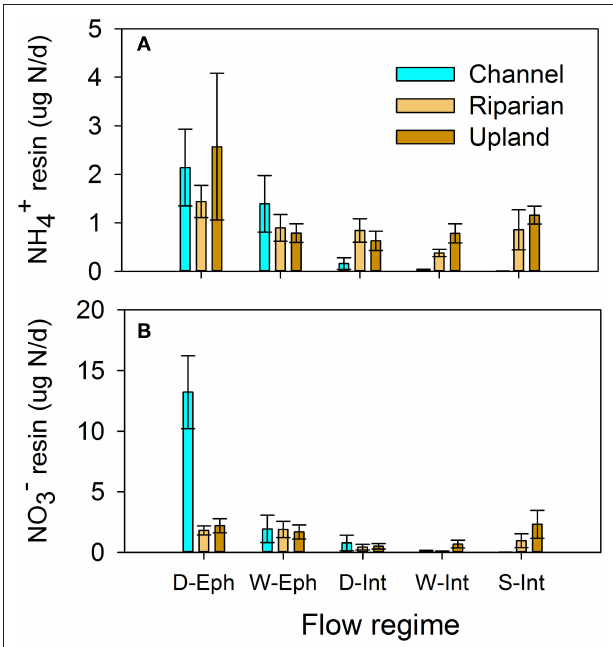
FIGURE 8 | (A) Ammonium and (B) nitrate availability as measured by resin bags and normalized by total days deployed during the monsoon across flow regimes, Dry ephemeral (D-Eph), Wet-ephemeral (W-Eph), Dry-intermittent (D-Int), Wet-Intermittent (W-Int), and Seasonally-Intermittent (S-Int), and positions (channel, riparian, and